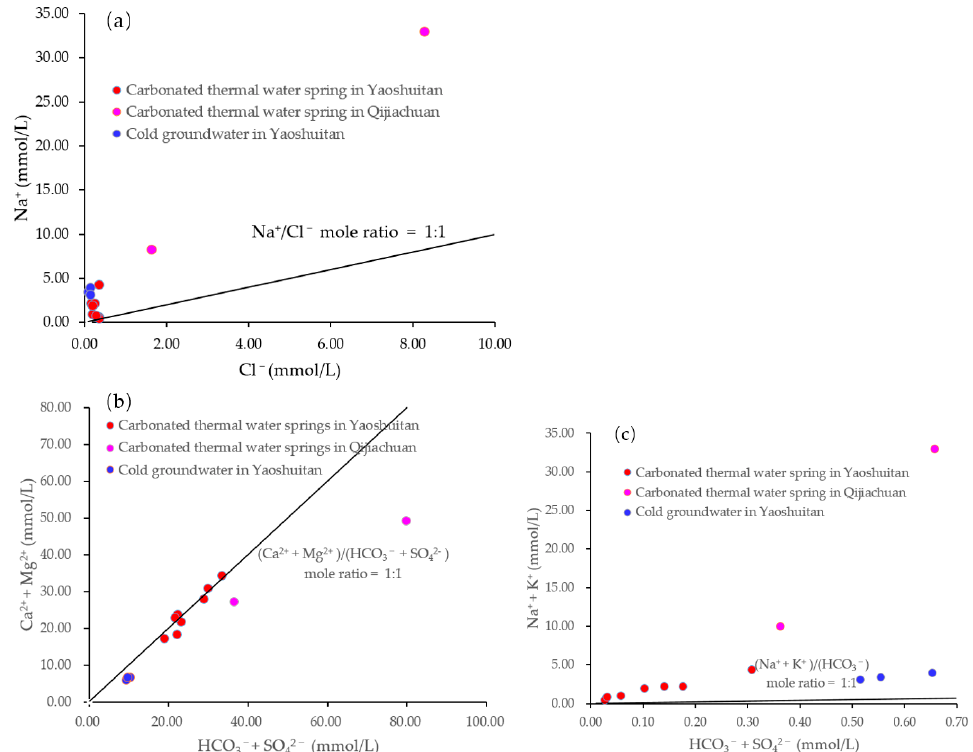
Figure 4. ( a ) Relationship between Na + and Cl − , ( b ) relationship between Ca 2+ + Mg 2+ and HCO 3 − + SO 42 − , ( c ) relationship between Na + + K + and HCO 3 − for water samples from Yaoshuitan and Qijiachuan.